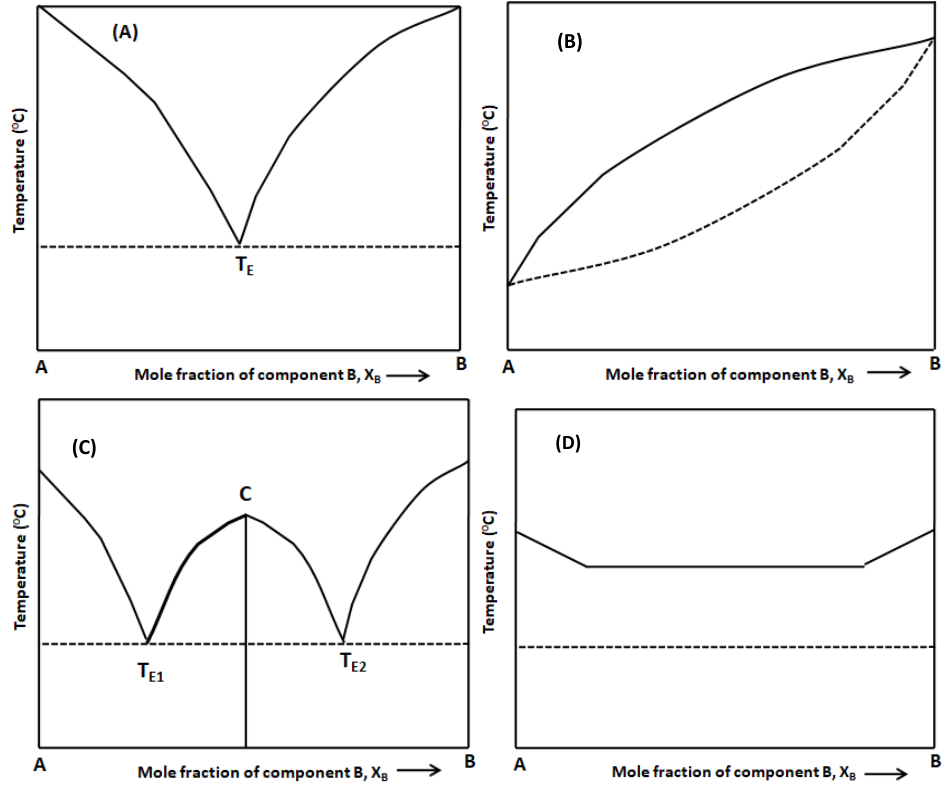
Figure 8. Schematic representation of Binary phase diagrams for ( A ) Eutectic formation [A and B—Binary components; T E —Eutectic temperature] [24,55,79,140], ( B ) Formation of solid solution [34], ( C ) Cocrystal formation [A and B—Binary components; C—Cocrystal phase; T E1 and T E2 —Eutectic temperatures] [24,73,140,145] and ( D ) Physical mixture [Dotted line-Onset of first component melting and dark line-Melting of the second component] [25].